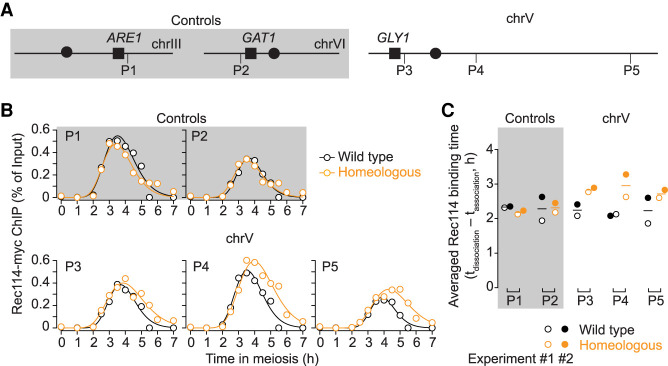
Persistent binding of Rec114 on homeologous chrV. (A) Primer pairs used for Rec114 ChIP-qPCR. Not to scale. P1 (on right arm of chrIII) and P2 (on left arm of chrVI) are internal controls (gray shading). P3 (left arm), P4 and P5 (right arm) are on chrV (no shading). (B) Rec114 binding kinetics for all five primer sets (experiment 1). (C) Averaged Rec114-binding duration for all five primer sets from two data sets. The binding duration is defined as dissociation time minus association time. Means are indicated by horizontal lines. Experiment 1 is shown as open circles and experiment 2 is shown as filled circles.